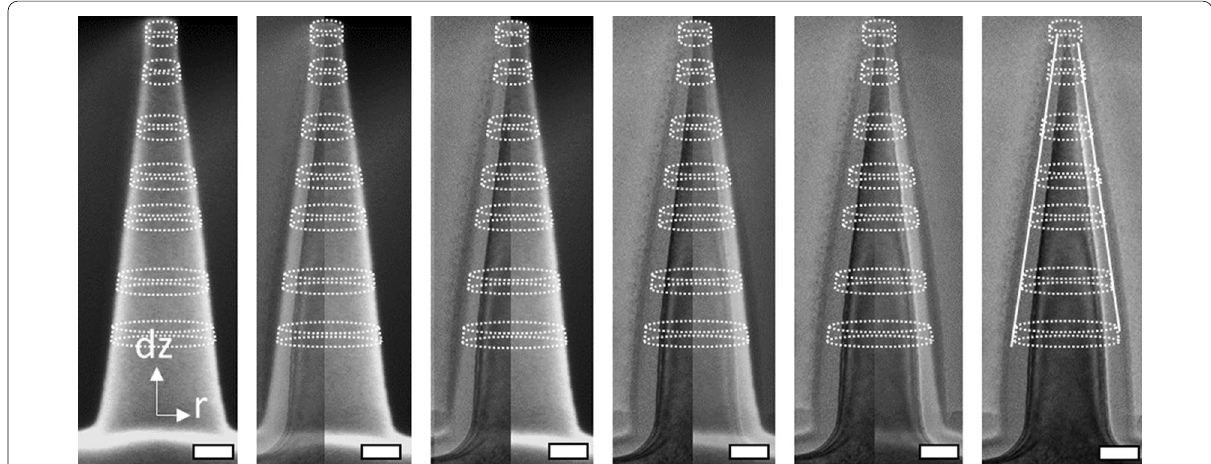
Fig. 5 Overlapping cross-sectional SEM and TEM images, in which the transparency of the SEM image is changed from 0 to 100% for both the left-half and right-half of the image. On the left side solely the SEM image is seen, whereas on the right side solely the TEM is observed. A coordinate system is drawn together with visual aids representing sliced vertical conical sections. The scale bars represent 50